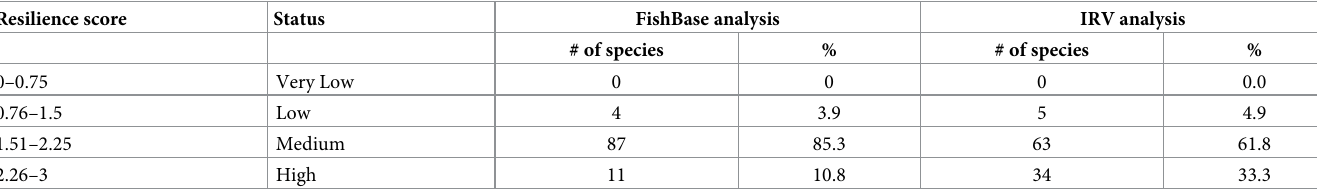
Table 9. Comparison of FishBase [26]and IRV analysis on resilience score for 102 teleost fish species. Resilience score